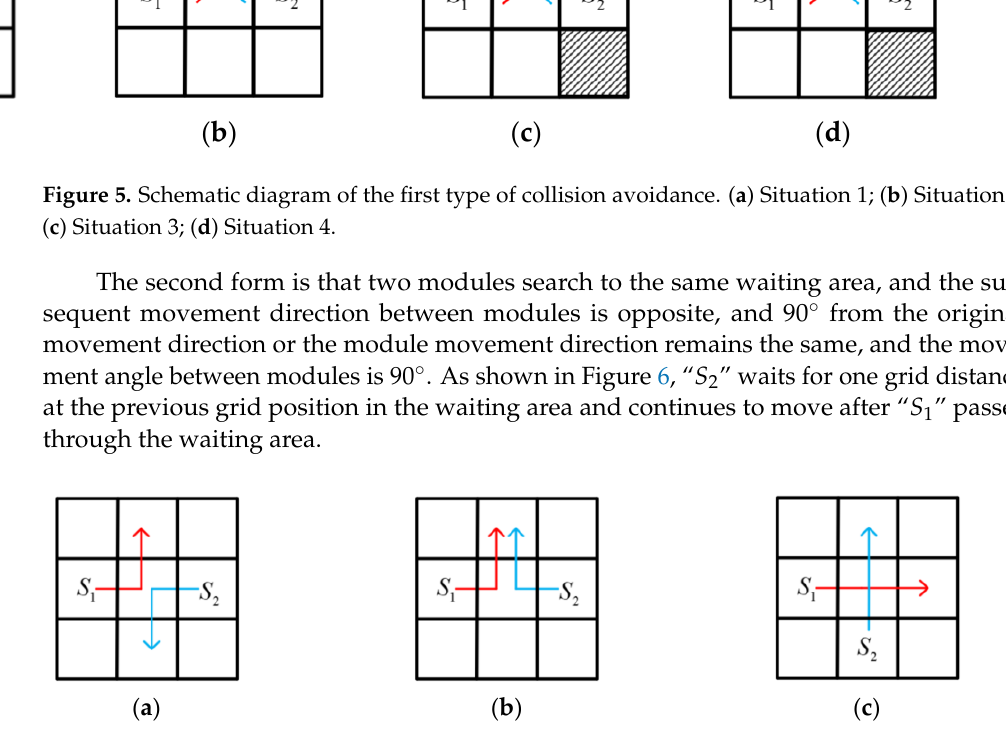
Figure 6. Schematic diagram of the second type of collision avoidance. ( a ) Situation 1; ( b ) Situation 2; ( c ) Situation 3.